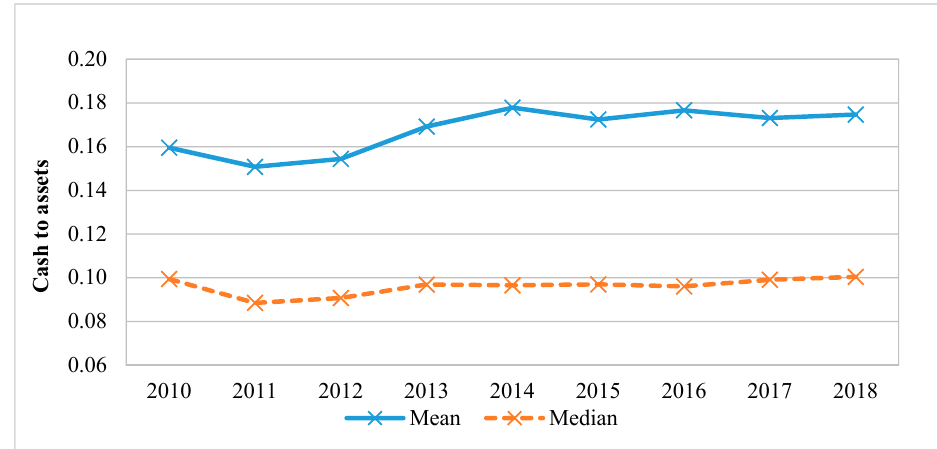
Figure 1. Time trend of cash holdings during the period 2010–2018. Note: This figure plots the evolution of the average and median cash to asset ratio over time for the full sample of 6929 UK non-financial non-utility firms during 2010–2018.